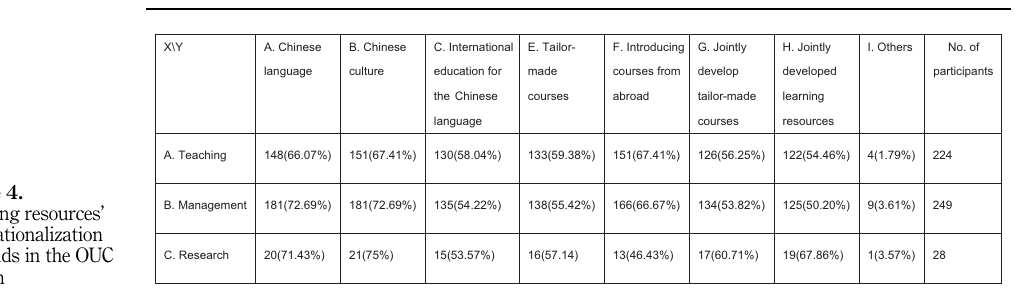
internationalization demands in the OUC system